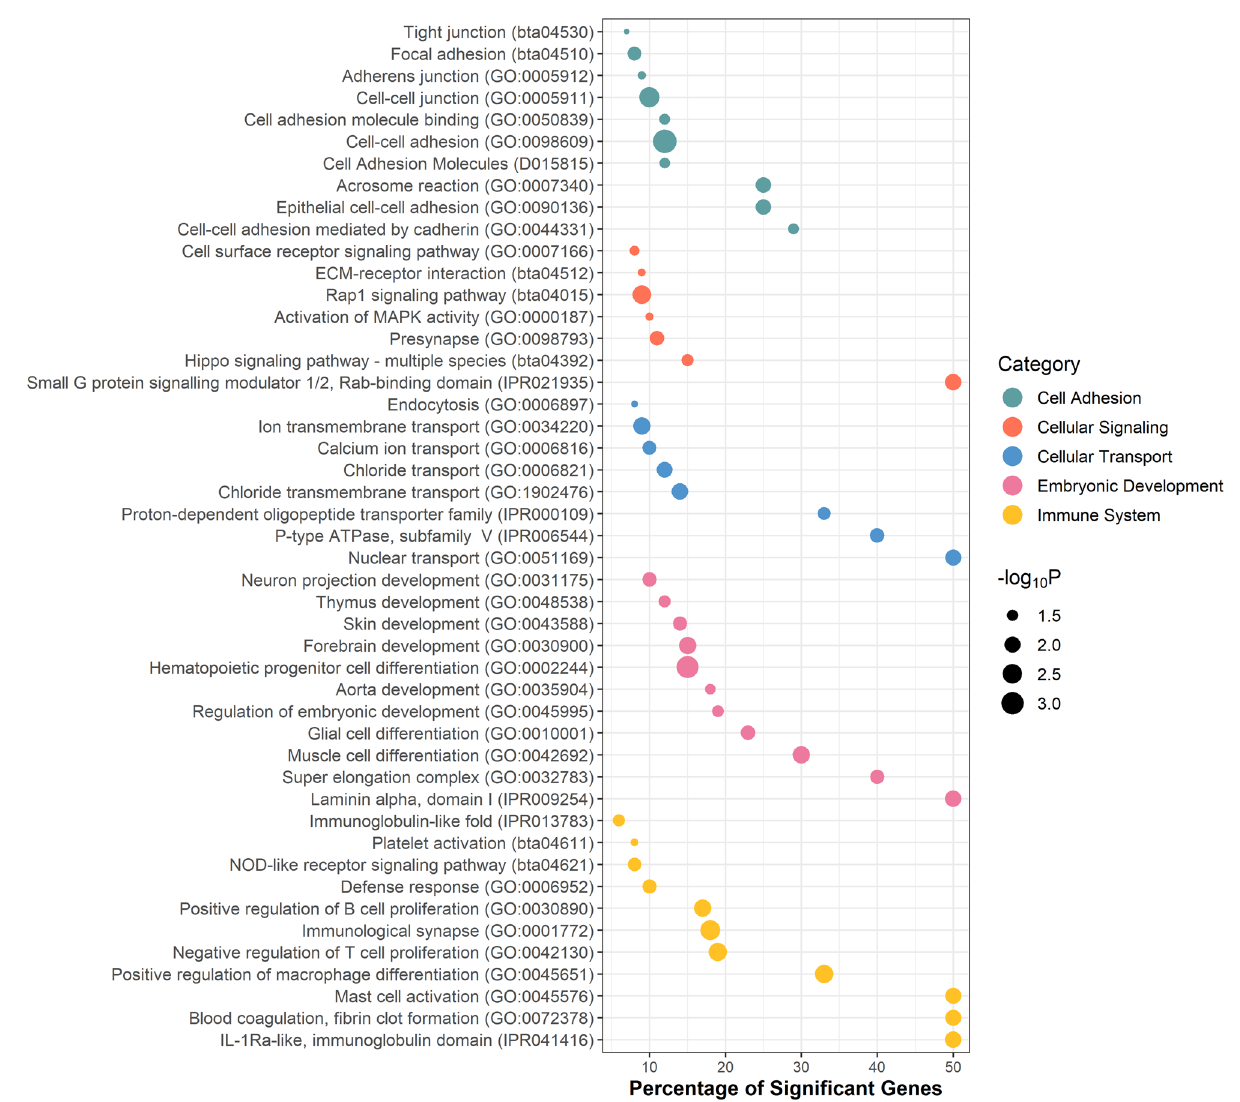
Figure 3. Functional gene-sets significantly enriched with genes associated with sire conception rate in Brown Swiss cattle. The y-axis displays the names of the gene-sets, the size of the dots represents the significance of the enrichment (− log 10 P -value, Fisher’s exact test) and x-axis represents the percentage of significant genes in each